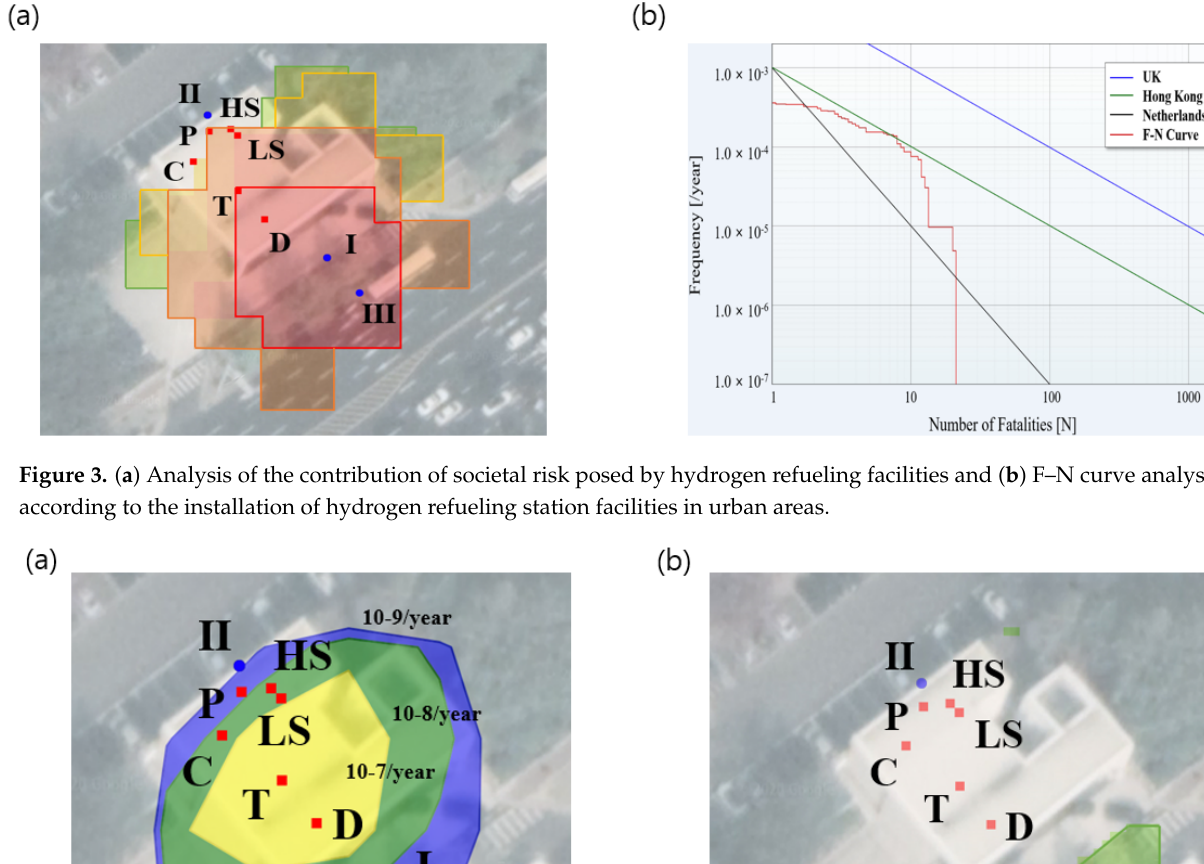
Figure 2. Contour mapping of individual risk in hydrogen refueling stations: ( a ) risk of each facility, ( b ) details of three locations, and ( c ) contribution of individual risk in each place without IPLs.